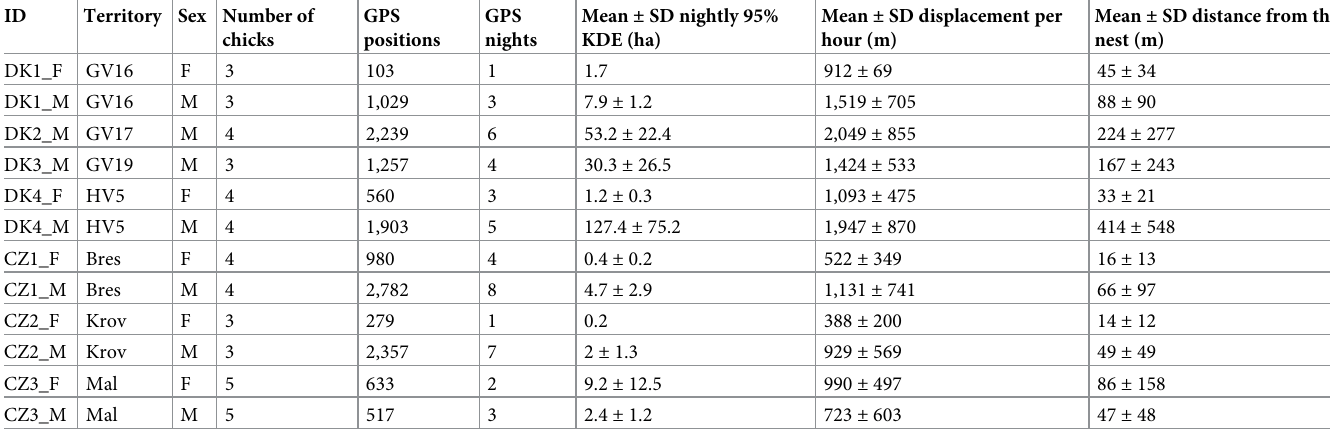
Spatial behavior. GPS positions obtained with < 4 satellites and a horizontal dilution of pre- cision (HDOP) value > 5 were removed from the data to remove GPS locations with a large loca- tion error [44]. In general, GPS units only recorded data from active owls, i.e. individuals that were outside the nest box/buildings (because the GPS could not acquire fixes inside buildings). We obtained the following variables from the raw GPS data: (1) nightly space use , calculated as 95% isopleths of Kernel Density Estimates (KDE) separately for each individual and night using the R package ‘adehabitatHR’ [45], and using the reference method (h ) as smoothing ref parameter. We only included nights with � 100 GPS positions and where we had obtained GPS positions for the entire night (i.e., we removed the final night of GPS recordings, if GPS fix acquisition did not last the entire night, because the battery ran out of power). (2) Distance from nest , the straight line distance of each GPS position from the nest. (3) Foraging trips > 200 m from the nest . We calculated the frequency and duration of foraging trips where individuals moved > 200 m from their nest. The duration of an individual trip was estimated from the ini- tial nest location until the owl was back at the nest, in both cases defined as a position � 25 m from the nest. (4) Hourly displacement , the sum of all straight line distances between GPS-posi- tions within each hour of the night, and (5) Nest visitation rate . Nest visitation rate could only Table 1. Overview of GPS-tagged little